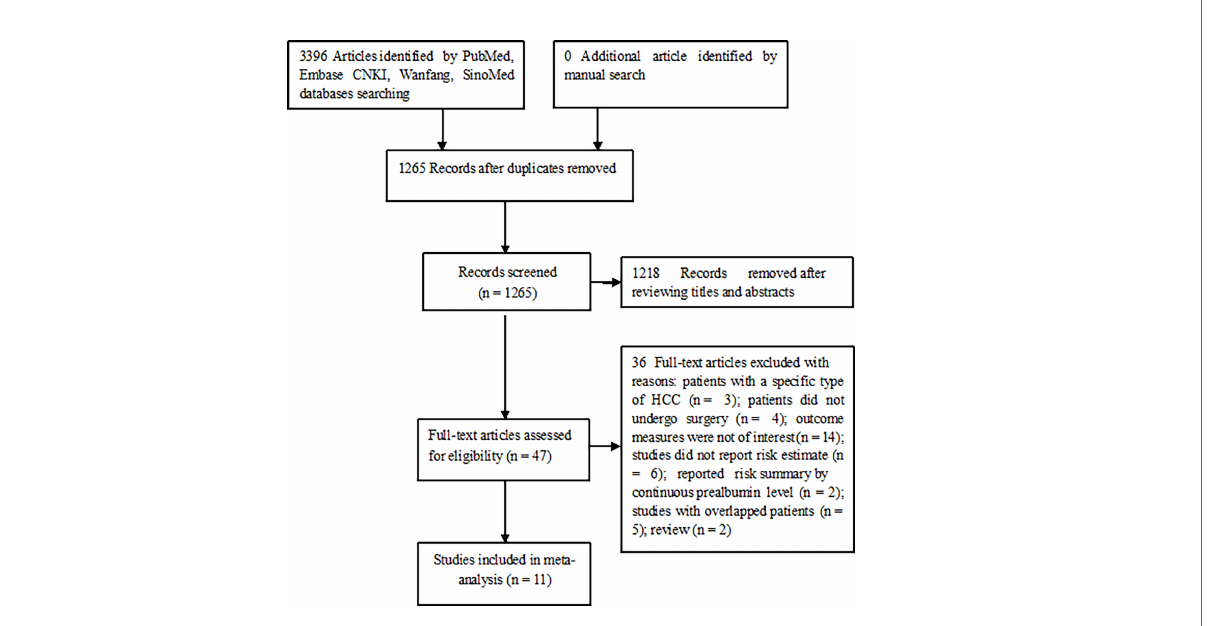
FIGURE 1 | Flowchart of the study selection